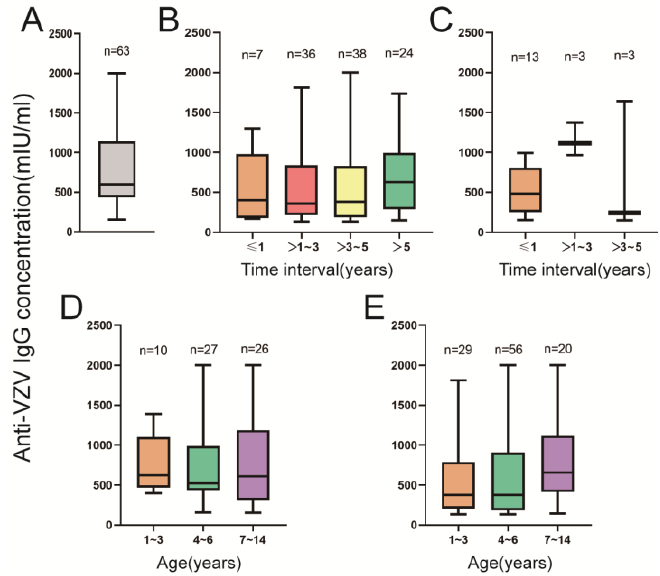
Figure 3. The persistence of anti-VZV IgG in participants with different vaccination histories. ( A ) The anti-VZV IgG level of non-vaccinated participants; ( B ) the anti-VZV IgG level of one-dose participants; ( C ) the anti-VZV IgG level of two-dose participants; ( D ) the anti-VZV IgG level of non- vaccinated participants in different age groups; ( E ) the anti-VZV IgG level of one-dose-vaccinated participants in different age groups.